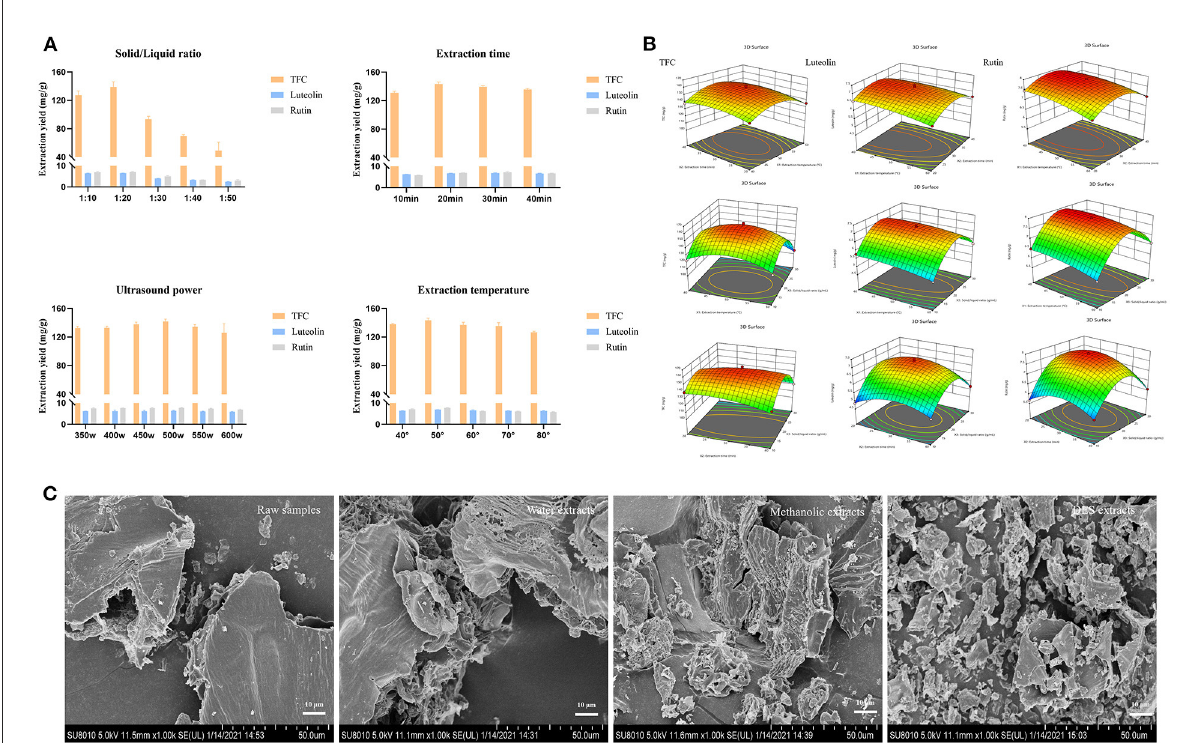
FIGURE5 Optimization of SOL extracts. (A) Single-factor experiments of solid/liquid ratio, extraction time, ultrasound power, and extraction temperature for TFC, luteolin, and rutin. (B) Response surface plots (three-dimensional) showing the effect of the extraction temperature (X1, ◦ C), extraction time (X2, min), and solid/liquid ratio (X3, g/mL) on the extraction yield of total flavonoids (Y1, mg/g), luteolin (Y2, mg/g), and rutin (Y3, mg/g) in SOL. (C) Microstructure of SOL samples with different extraction solvents (1000 × ).